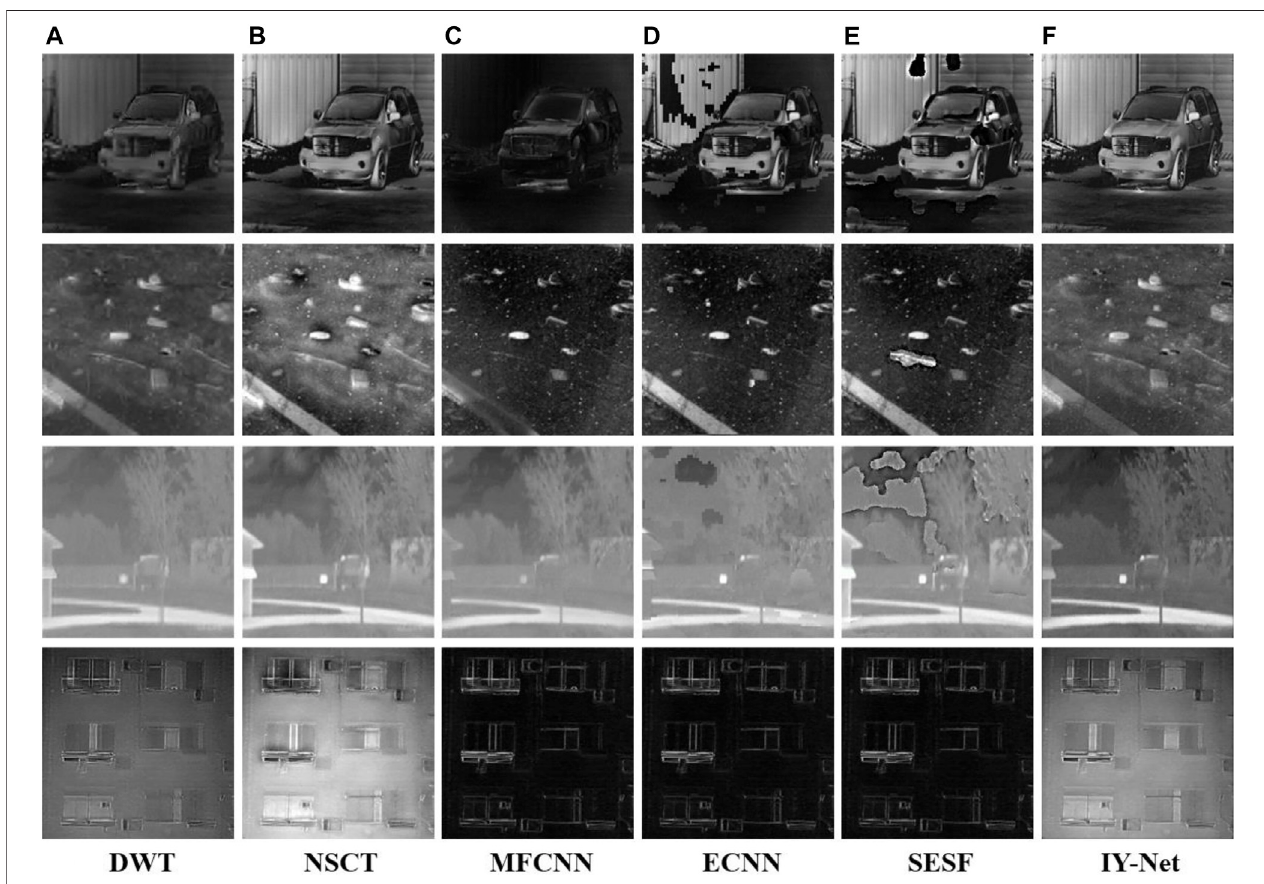
FIGURE 7 | Experiment on 4 pairs of infrared intensity and polarization images. (A) DWT, (B) NSCT, (C) MFCNN, (D) ECNN, (E) SESF, (F) IY-Net.